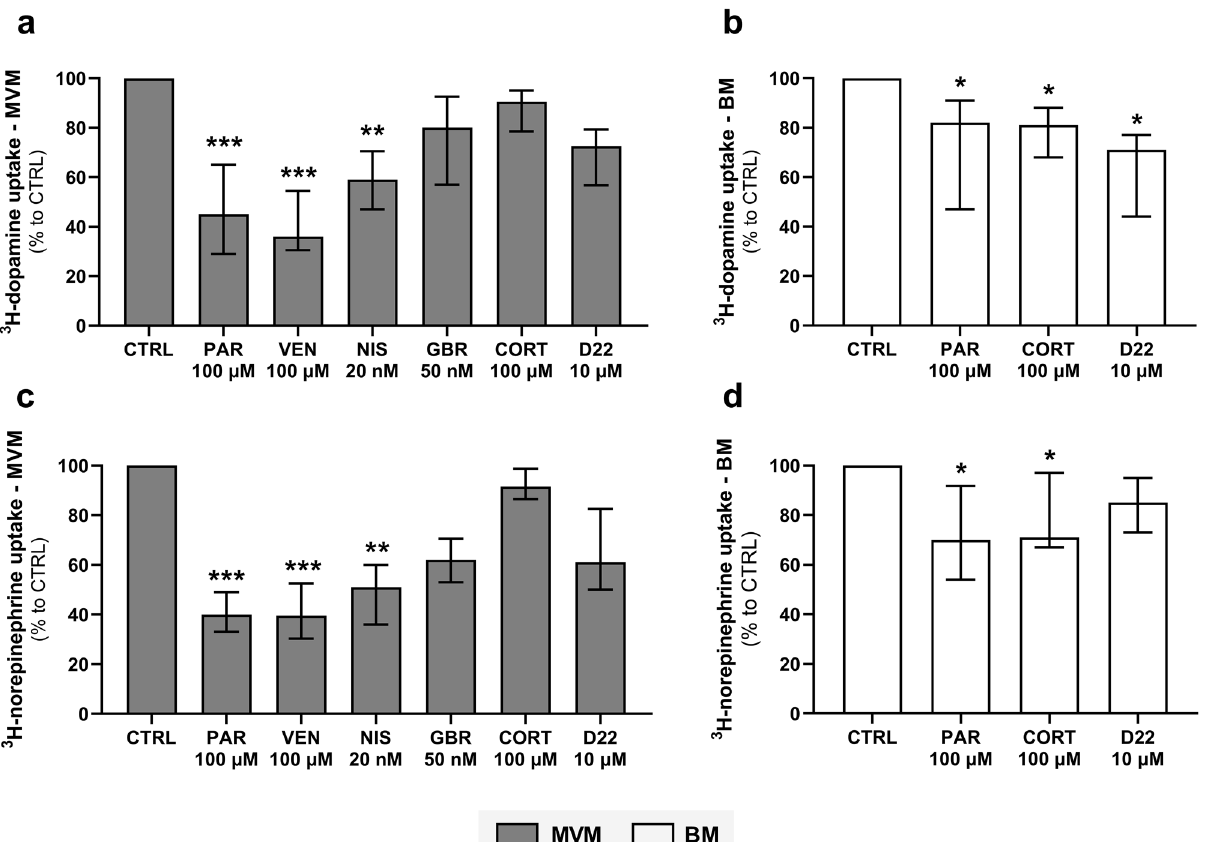
Figure 4. Differential inhibitor sensitivity of 3 H-dopamine and 3 H-norepinephrine transport systems in human placental membranes. One-minute uptake of 3 H-dopamine ( a , b ) and 3 H -norepinephrine ( c , d ) was evaluated in the presence of 100 µM paroxetine (PAR), 100 µM venlafaxine (VEN), 20 nM nisoxetine (NIS), 50 nM GBR 12935 (GBR), 100 µM cortisol (CORT), and 10 µM decynium-22 (D22). Results are presented as